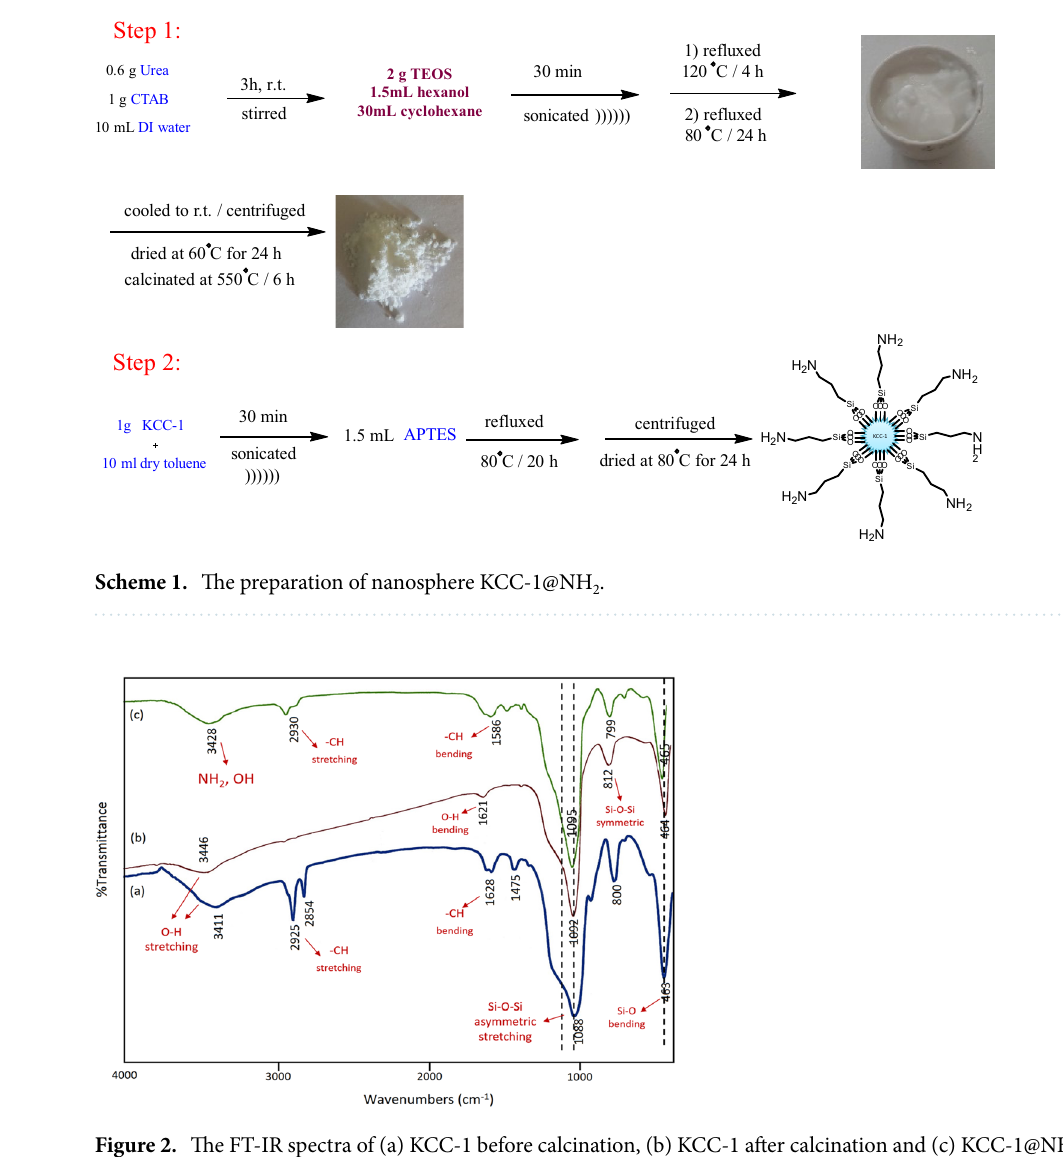
Figure 2. The FT-IR spectra of (a) KCC-1 before calcination, (b) KCC-1 after calcination and (c) KCC-1@NH 2 .